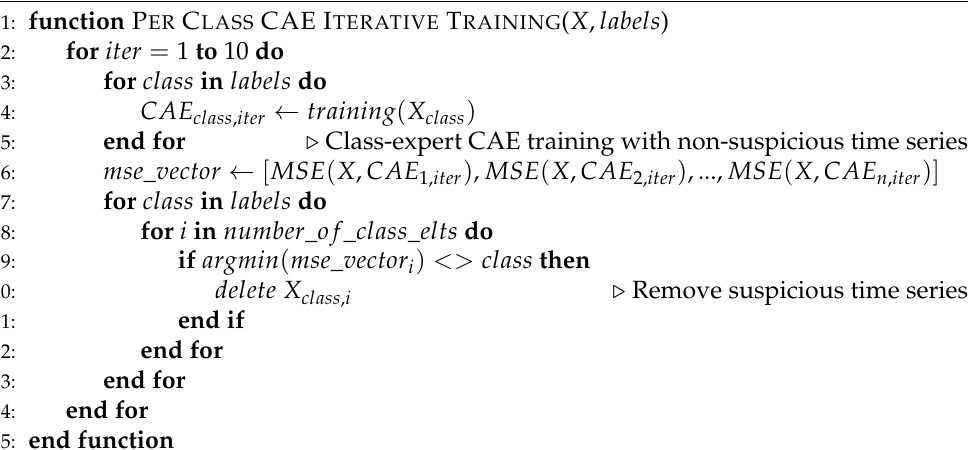
Algorithm 1 Iterative training of CAE, with removal of suspicious